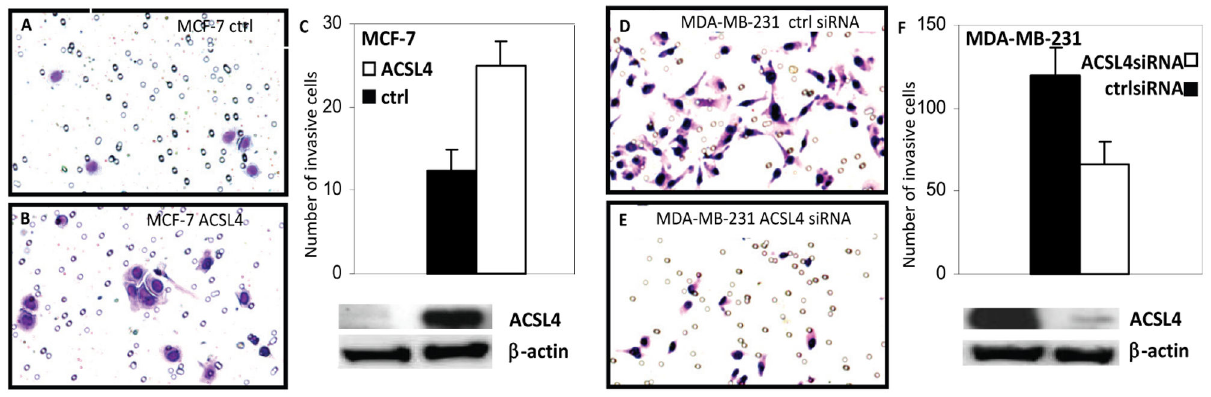
Figure 4. Effect of ACSL4 expression on invasion capability of breast cancer cells. MCF-7 cells were stably transfected with ACSL4 cDNA utilizing a lentivirus vector, and control- and ACSL4-tranfected cells compared with respect to invasive potential as described in the text. Panel A , control MCF-7, B , ACSL4-MCF-7, C , bar graph indicating the average number of cells per field in 3 separate chambers (p=0.005), and an immunoblot blot analysis of ACSL4 expression in control and ACSL4- MCF-7 cells. For panels D , E and F , MDA-MB-231 were treated with either control or ACSL4 siRNA (20nM), and control and experimental cells were compared with respect to invasive potential as described in the text. Panel D , control siRNA-treated cells, E , ACSL4 siRNA-treated cells, F , bar graph indicating the average number of cells per field in 3 separate chambers (p=0.005), and an immunoblot blot analysis of ACSL4 expression in control siRNA and ACSL4 siRNA-treated